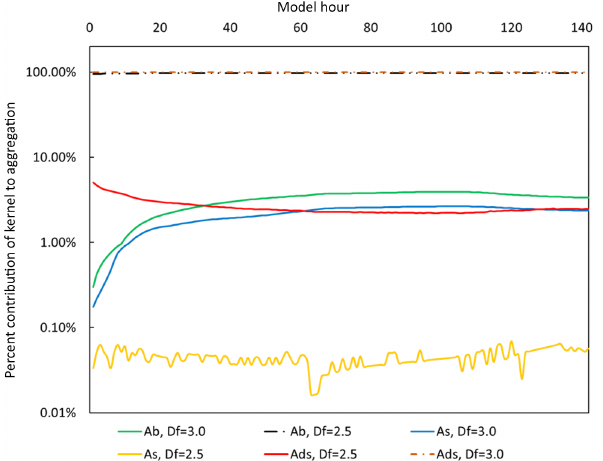
Figure 5. Percentage of aggregation rate for each collision kernel ( A B : Brownian; A S : shear; A DS : differential sedimentation) when considering a hypothetical eruption on 5 May, beginning at 00:00Z and ending at 09:00Z, for two fractal dimensions, D f = { 3.0, 2.5 } . Constant eruption rate = 4 × 10 6 kgs − 1 .